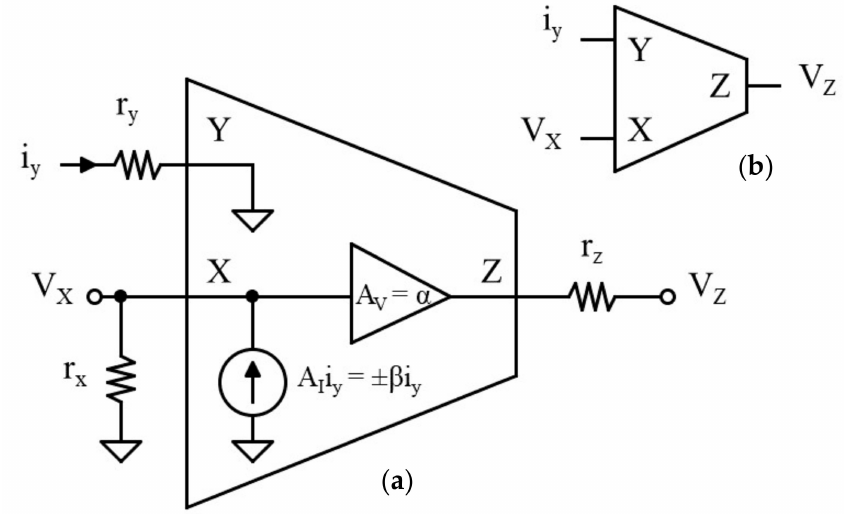
Figure 2. ( a ) Internal block structure of the VCII; ( b ) VCII device symbol.